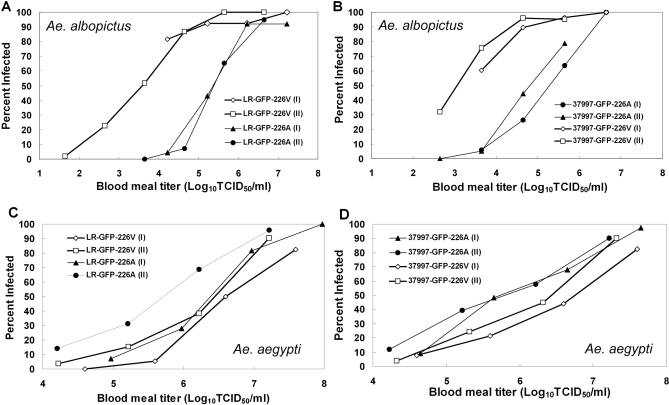
Effect of E1-A226V Mutation on CHIKV-GFP Viruses Ae. albopictus and Ae. aegypti Midgut InfectivityPercent of orally infected Ae. albopictus (A, B) and Ae. aegypti (C, D) mosquitoes presented with blood meals containing various concentration of eGFP-expressing CHIK viruses. Serial 10-fold dilutions of viruses in the backbone of Reunion (LR-GFP-226V and LR-GFP-226A) (A, C) and 37997 (37997-GFP-226A and 37997-GFP-226V) (B, D) strains of CHIKV were made in L-15 medium followed by mixing the samples with defibrinated sheep blood. Mosquitoes were dissected at 7 dpi and eGFP expression in infected midguts was analyzed by fluorescence microscopy. A mosquito was considered infected if at least one foci of eGFP-expressing cells was present in the midgut. The experiments were performed twice for each virus (I and II).